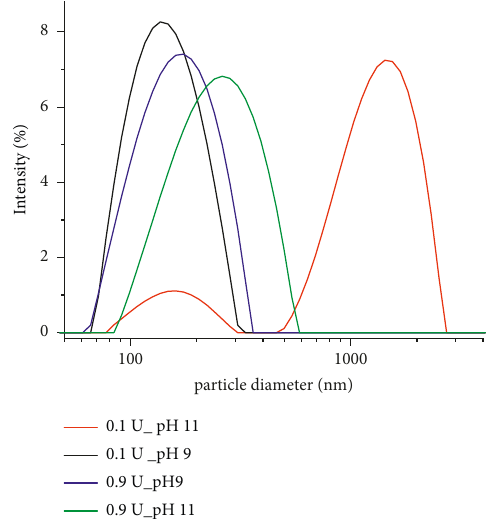
Figure 4: Particle diameter of Ag NPs obtained under 0.1g or 0.9g of U. maydis at pH 9 and pH 11 after 100 seconds of sunlight exposure at room